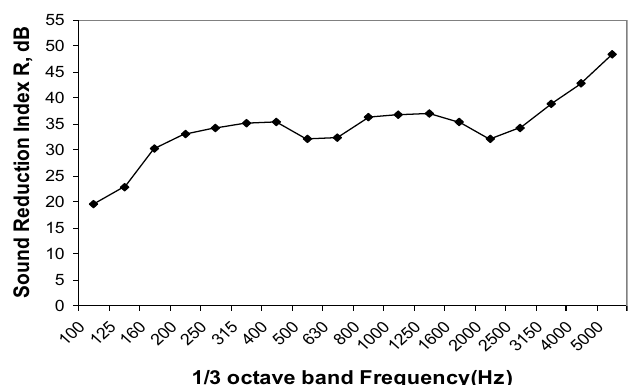
Fig. 3. Sound reduction index ( R ) in 1/3-octave